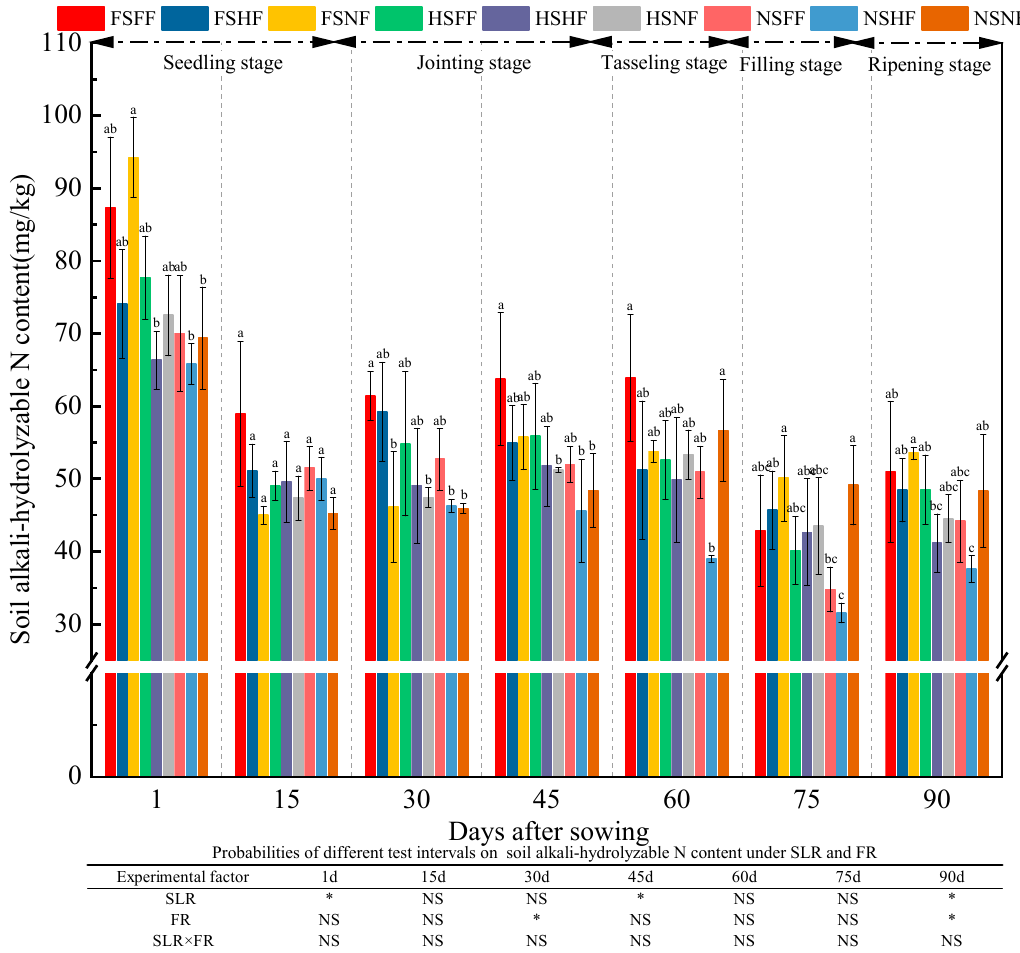
Figure 10. Effects of SLR and FR on soil alkali–hydrolysable N content. Note: Bars represent means ± standard deviation ( n = 3) with different letters indicating significant differences based on LSD ( p ≤ 0.05). SLR, sugarcane leaf return; FR, fertilizer reduction.